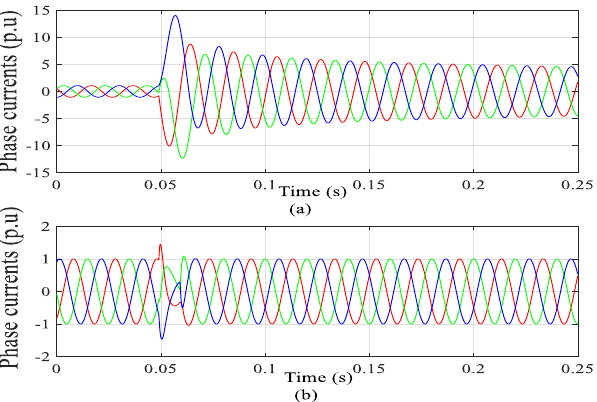
Figure 1. Typical fault current signature of a 50 MVA generation unit. ( a ) SG ( b ) type-four wind [2].